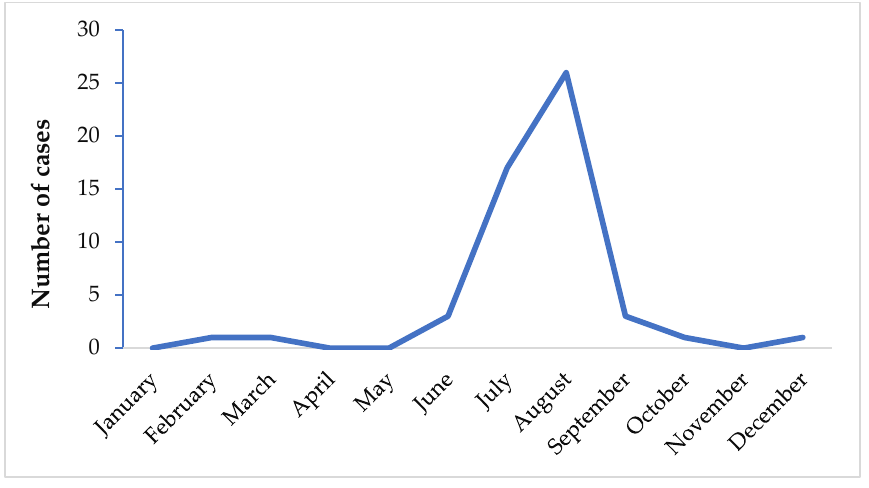
Figure 3. Airport malaria: period of the year in Europe when the greatest number of infections occurs [6,8,25,26,86–88].